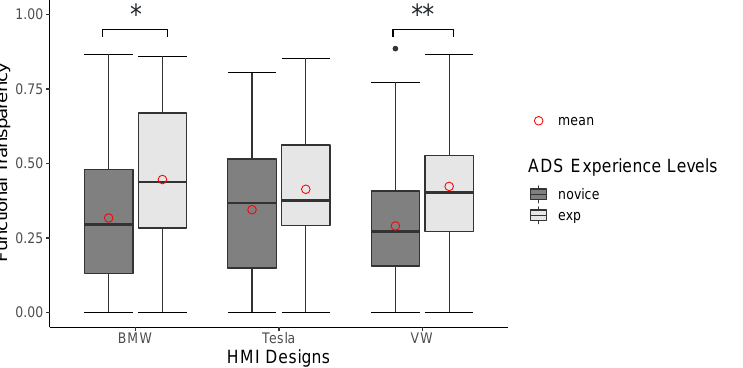
Figure 4. Comparing levels of ADS experience given HMI designs (exp stands for experienced in ADS experience levels). ** p < 0.05, * p < 0.1.